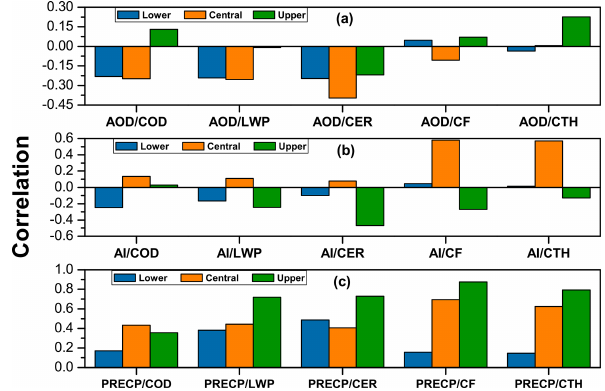
Figure 15. Correlation analysis of (a) AOD vs. cloud properties, (b) AI vs. cloud properties, and (c) PRECP vs. cloud properties for upper, central, and lower South